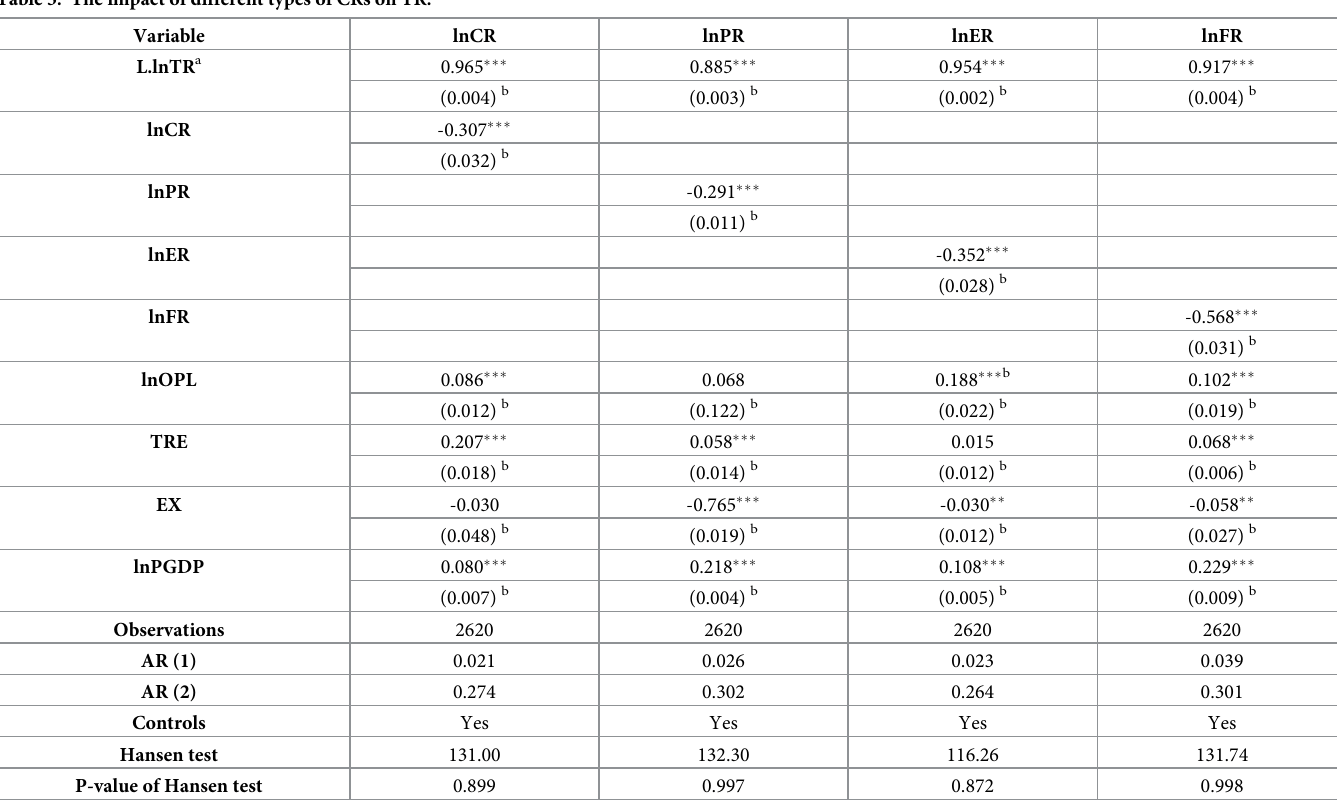
Table 5. The impact of different types of CRs on